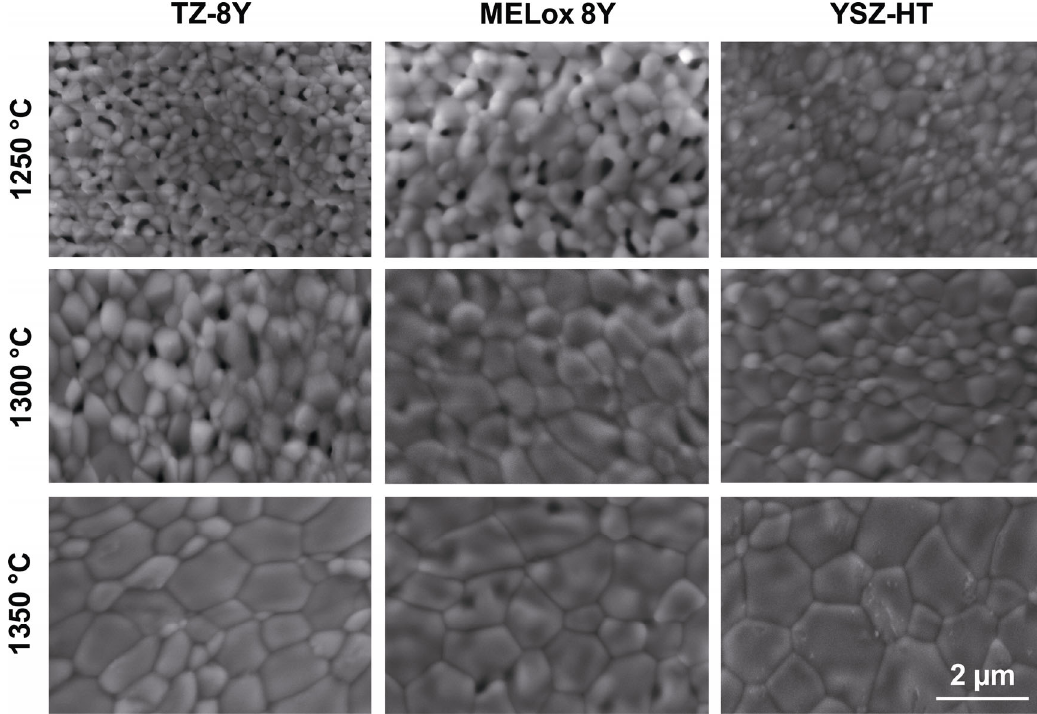
Fig. 6 SEM images showing the surface microstructure of the pellets made of different YSZ powders and sintered at different temperatures. The scale bar applies to all the